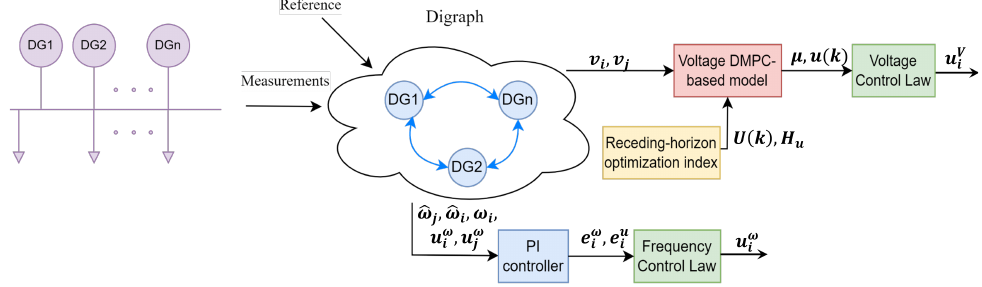
Figure 4. Diagram of the implemented secondary predictive